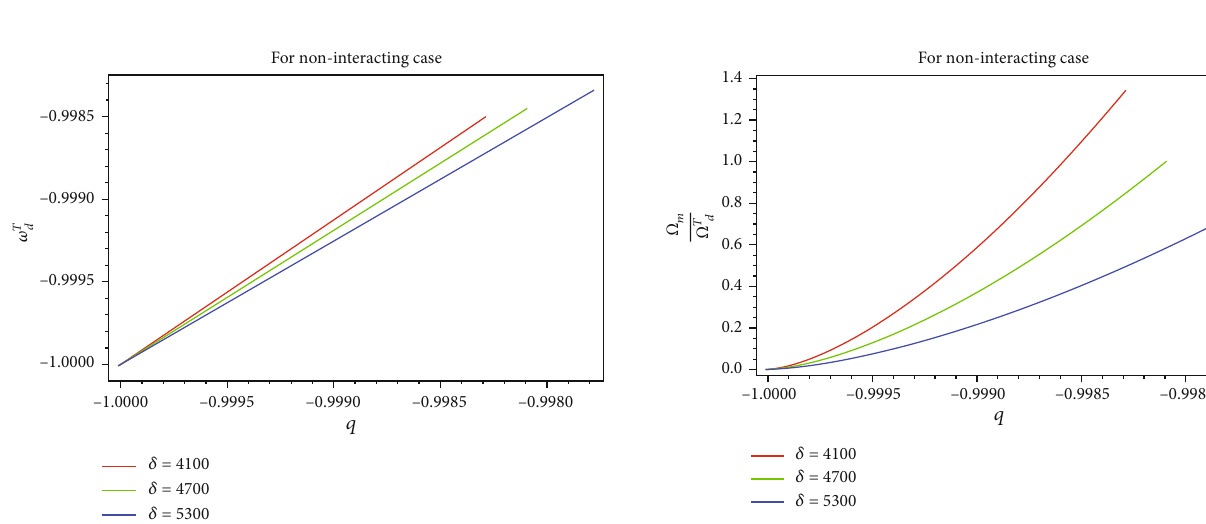
Figure 13: Behavior of coincidence parameter ~ r = Ω deceleration parameter q .